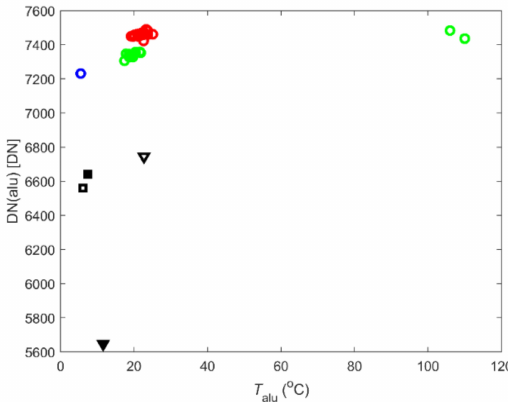
Figure 4. Scatter plot of DN on the aluminum foil surface (field survey data, corrected with sigma = 30) as a function of T alu ( ◦ C), with circles indicating laboratory measurements, in green T air = 19.8 ◦ C, red T air = 22 ◦ C, and blue T air = 19.3 ◦ C; black squares/triangles indicate April/August field surveys, with open/filled symbols representing